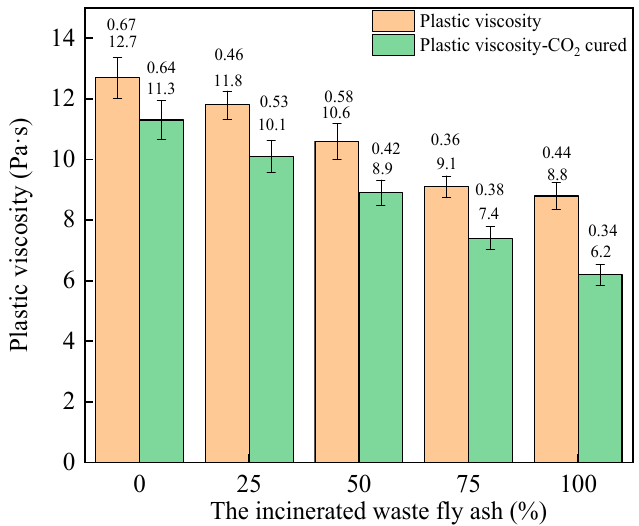
Figure 4. The plastic viscosity of the fresh RPC.